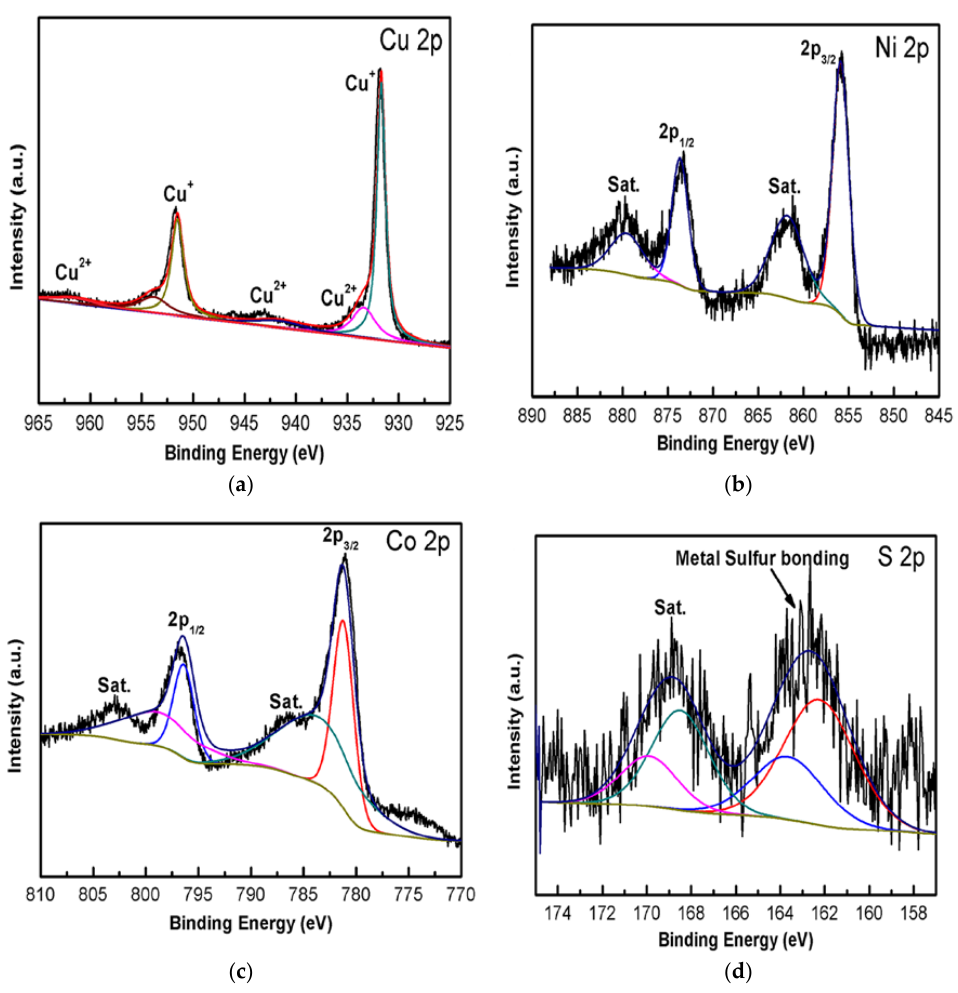
Figure 4. X-ray photoelectron spectroscopy (XPS) spectra of ( a ) Cu 2p, ( b ) Ni 2p, ( c ) Co 2p and ( d ) S 2p for the CuO/Cu 2 O@NiCo 2 S 4 -4 composite.